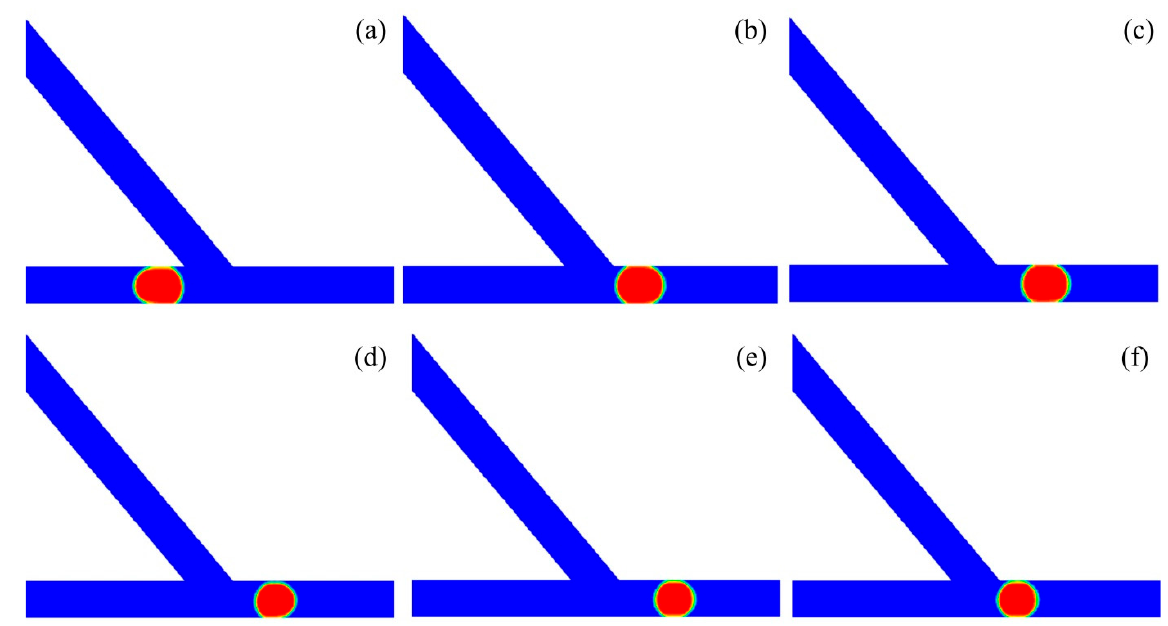
Figure 13. Droplet sorting in the asymmetric acute junction with the angle of θ = 50° at various interfacial tensions. ( a ) V d / w 3 = 0.85, σ = 3 mN/m, ( b ) V d / w 3 = 0.85, σ = 7 mN/m, ( c ) V d / w 3 = 0.85, σ = 12 mN/m, ( d ) V d / w 3 = 0.6, σ = 3 mN/m, ( e ) V d / w 3 = 0.6, σ = 7 mN/m 4, ( f ) V d / w 3 = 0.6, σ = 12 mN/m.